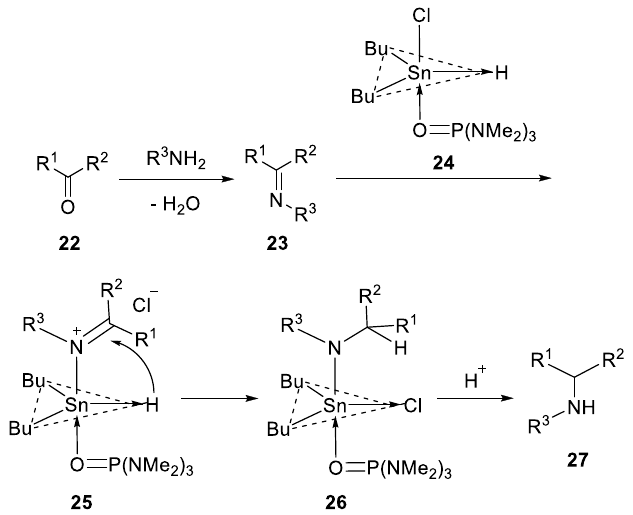
Scheme 7. Plausible mechanism for the reductive amination of carbonyls with amines.